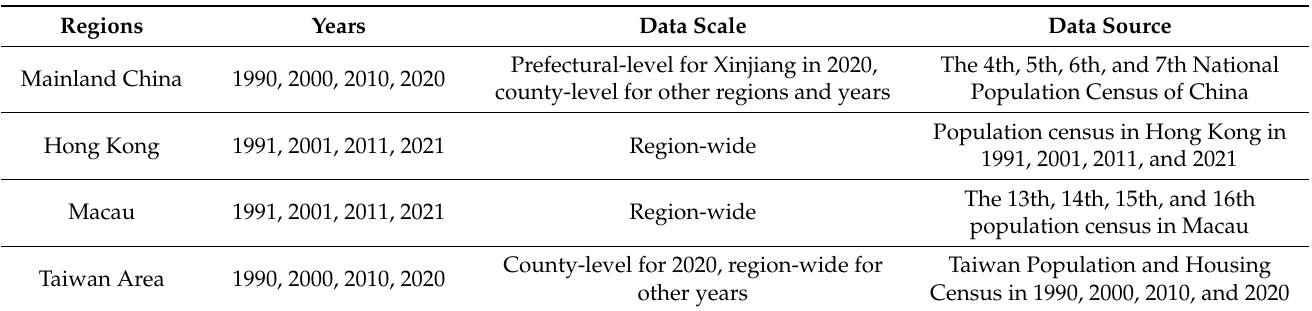
Table 1. Source of population data for the four regions of China.